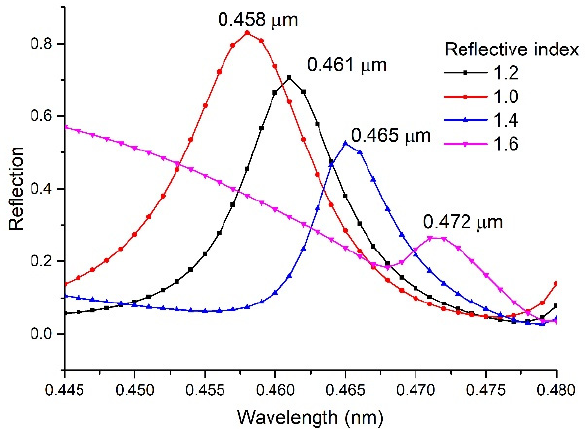
Figure 12. The trend of peak wavelength position with the refractive index.